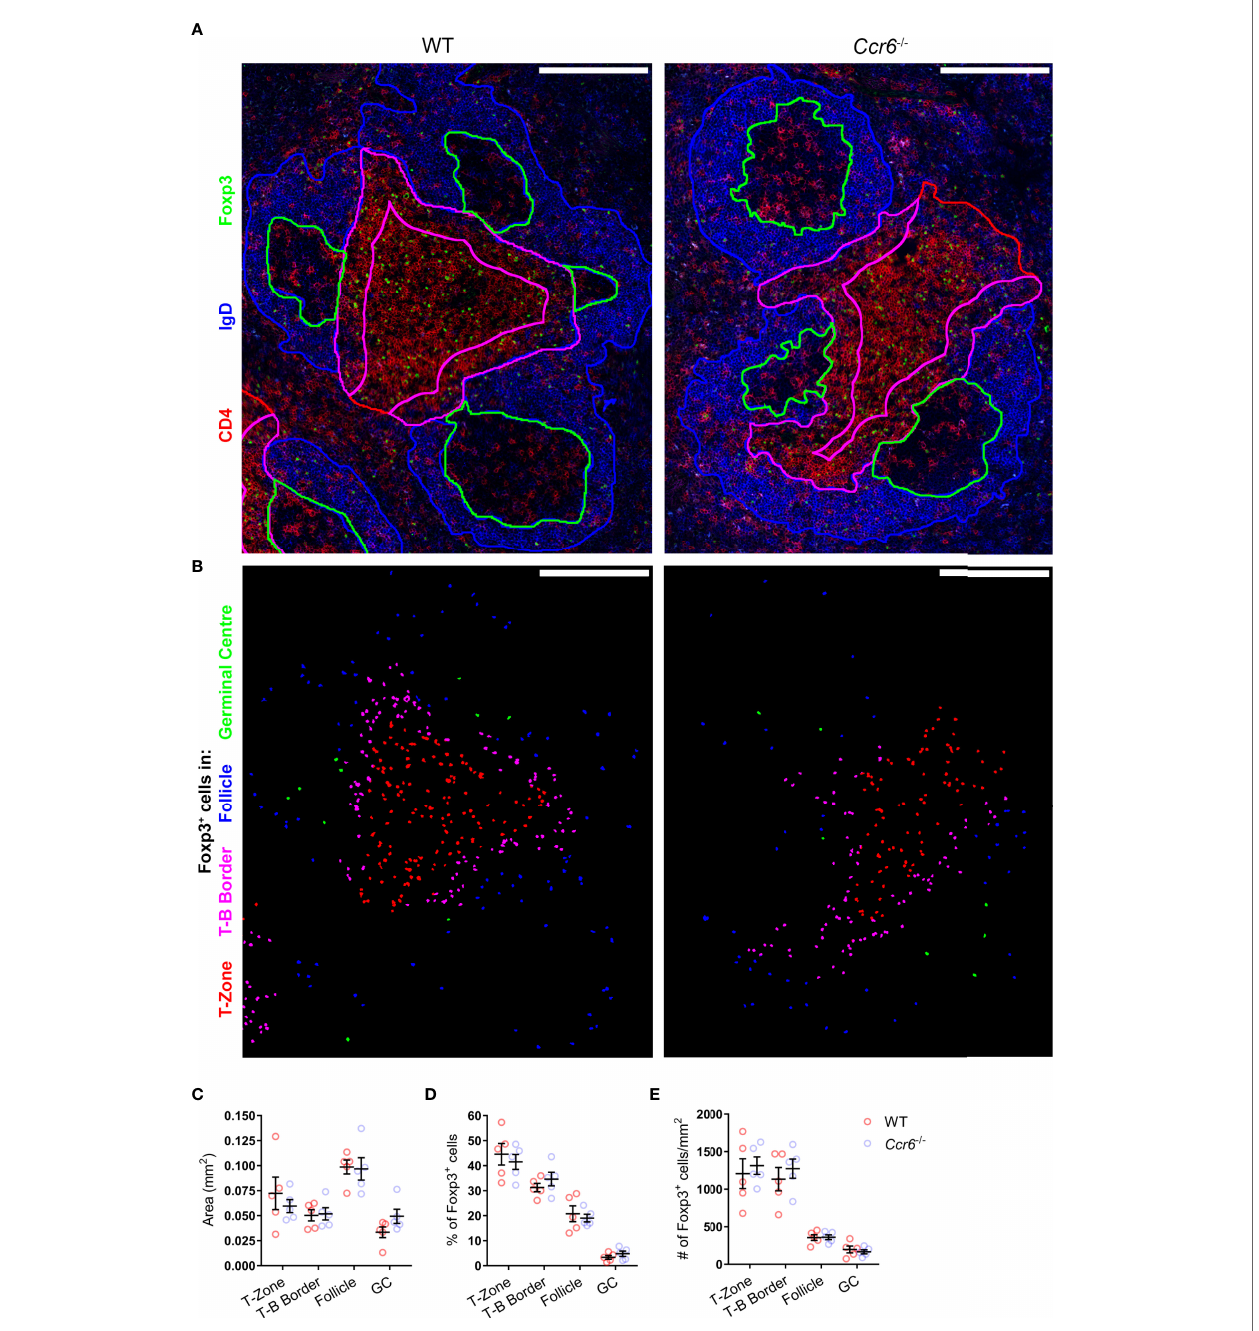
FIGURE 5 | CCR6-de fi ciency does not affect splenic Foxp3 + cell distribution during the peak of SRBC immunization. (A) Localisation of Foxp3 + cells in PFA and acetone fi xed/permeabilized spleen sections from day 6 i.p. SRBC immunized WT and Ccr6 -/- mice. Sections were stained with antibodies against CD4 (red), IgD (blue) and Foxp3 (green). Based on CD4 and IgD staining, the following areas are outlined: follicles (blue), GCs (green), T-B border (magenta), and T-zone (red). Scale bar: 200µm. (B) Identi fi cation of Foxp3 + cells from (A) , colour-coded based on localisation within the T-zone (red), T-B border (magenta), follicle (blue), or GC (green). (C) Average area (mm 2 ) of delineated splenic compartments from (A) . (D) Percentage and (E) number/mm 2 of Foxp3 + cells within each splenic niche, quanti fi ed from Figure 5.B. (A, B) Images representative of n=5 mice/strain, 2-6 images/mouse. (C – E) Each dot represents the average of technical replicates per biological replicate, n=5 mice/strain ± SEM. Two-tailed unpaired Student ’ s t